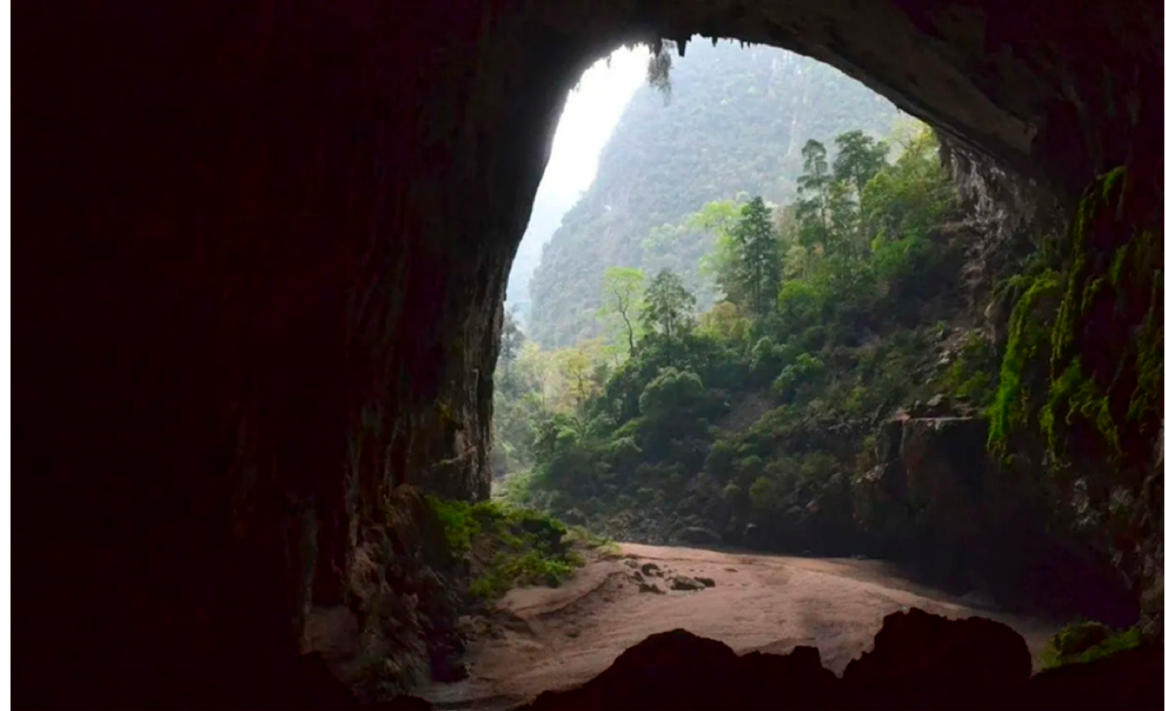
Figure 10. Large circular door in Kong’s cave (2005). https://www.debate.com.mx/mundo/Las-cuevas-de-King-Kong-po-